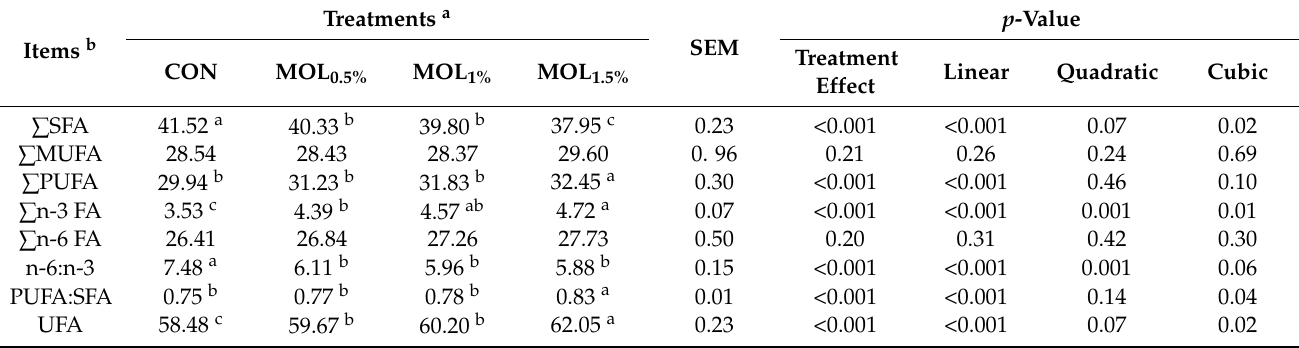
Table 6. Meat FA profile (% of total FA) of growing rabbits fed the experimental diets.